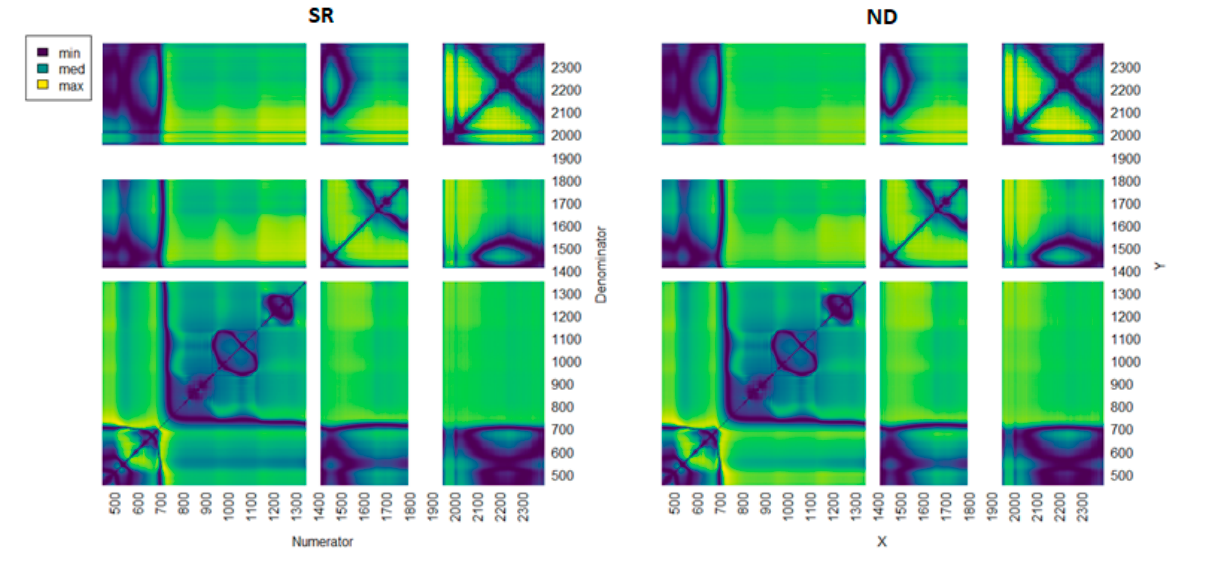
Figure 4. Coefficient of determination Heatmaps between calculated vegetation indices (VIs) (both Simple Ratios, SR, and Normalized Difference, ND) vs. nitrate content ([Nitrate]) for the entire dataset (including Exp. A, Exp. B, and Exp. C; see Table 1 for further details). White bands correspond to the bands which have been removed from the database, because of significant atmospheric effects.